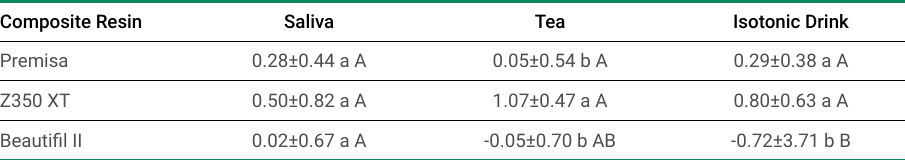
*Capital letter indicates statistical difference among columns. Lowercase indicates statistical difference among